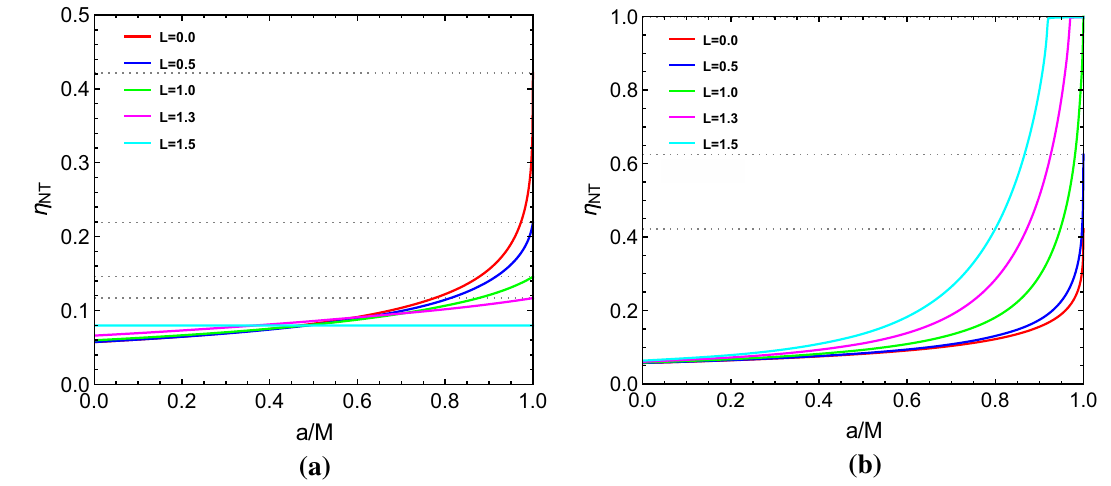
Fig. 3 Novikov-Thorne radiative efficiency η NT as a function of a / M for a few different values of the parameter L for a regular and b singular black hole